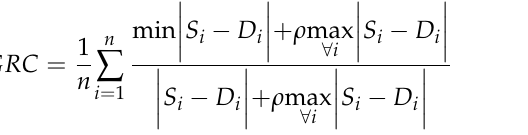
Table 2. Constant current pulse experiment steps.